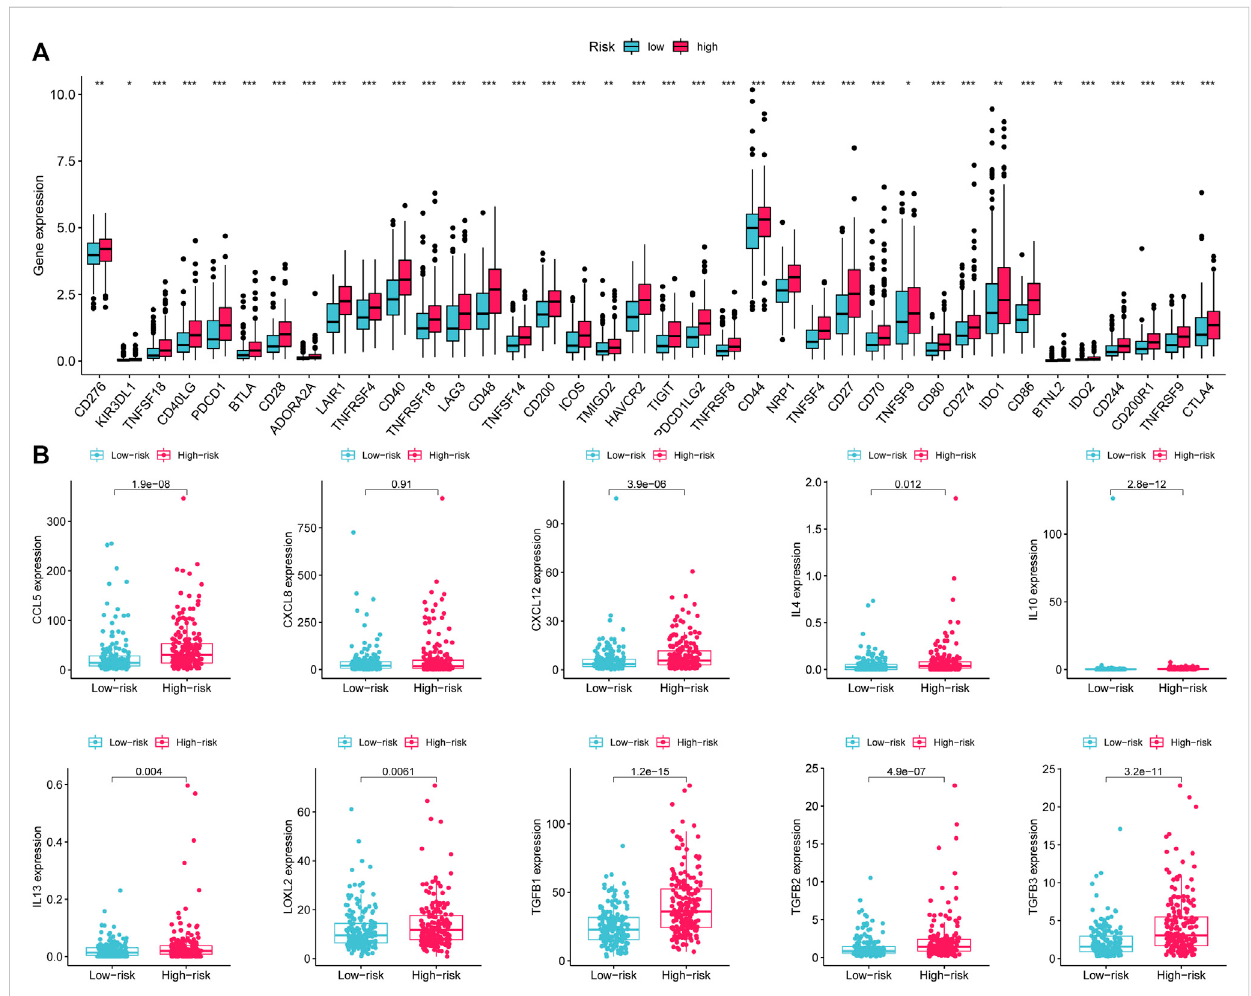
FIGURE 11 Variations in the expression of immune-associated genes between low- and high-risk groups. (A) Expression of immune checkpoints in high- and low-risk patients with gastric cancer. (B) Expression of immunosuppressive cytokines across the two groups. * p < 0.05; ** p < 0.01; *** p <